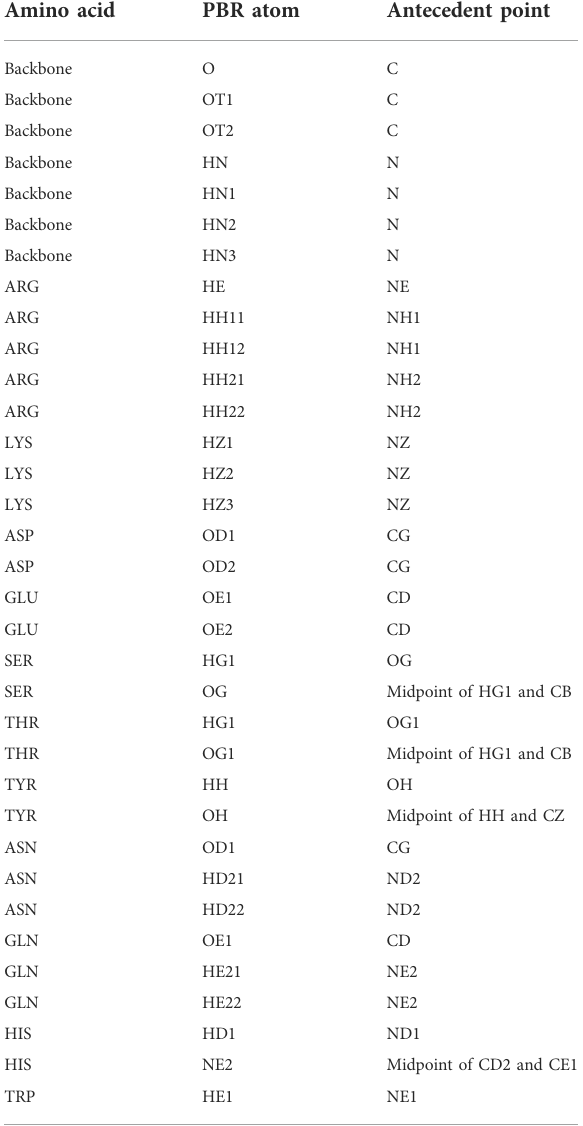
TABLE 1 Polar atom and their antecedent atom names considered for PBRandEBAidenti fi cation.AtomnamesfollowtheCHARMMPDB atom